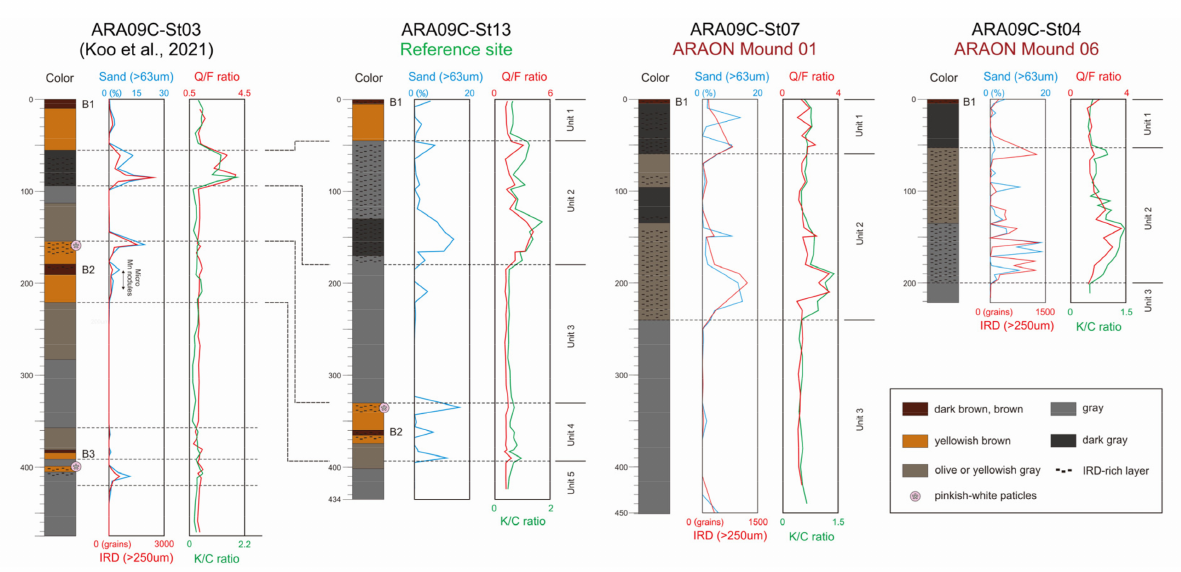
Figure 2. Vertical lithology profiles of the sediment cores in the background site and ARAON Mounds, marked with color cycles, ice-rafted debris (IRD) and/or sand contents, quartz/feldspar (Q/F), and kaolinite/chlorite (K/C) ratios. The correlation of core ARA09C-St03 in the inner slope of Chukchi Rise [23] is based upon color cycles, sand content, and mineral ratios. Table 2. Average bulk mineral compositions (%) and Q/F ratio in the studied cores and their